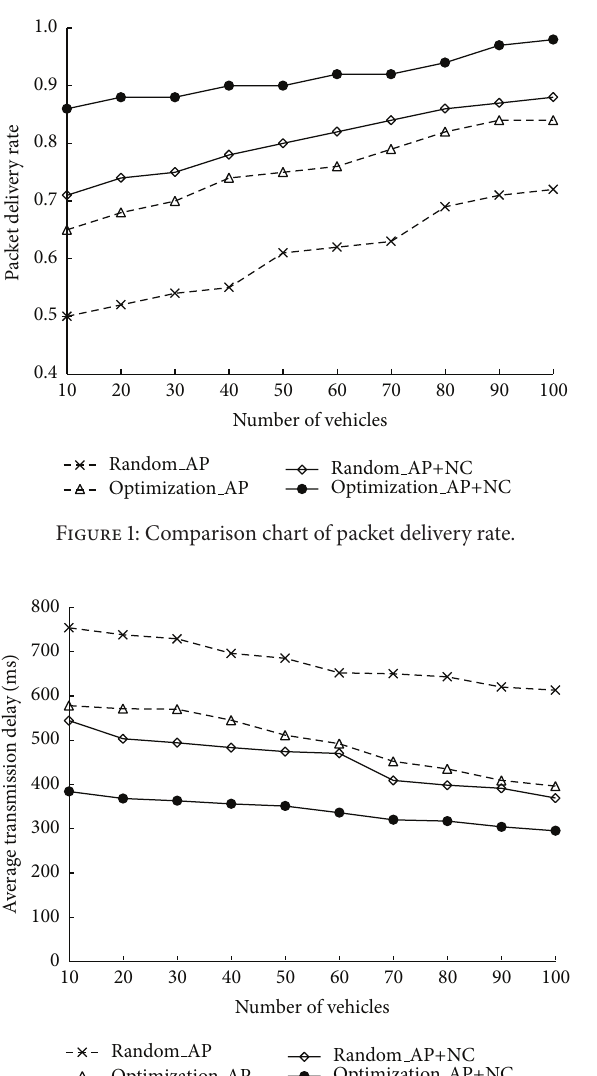
of random AP and optimized AP. Random AP+NC